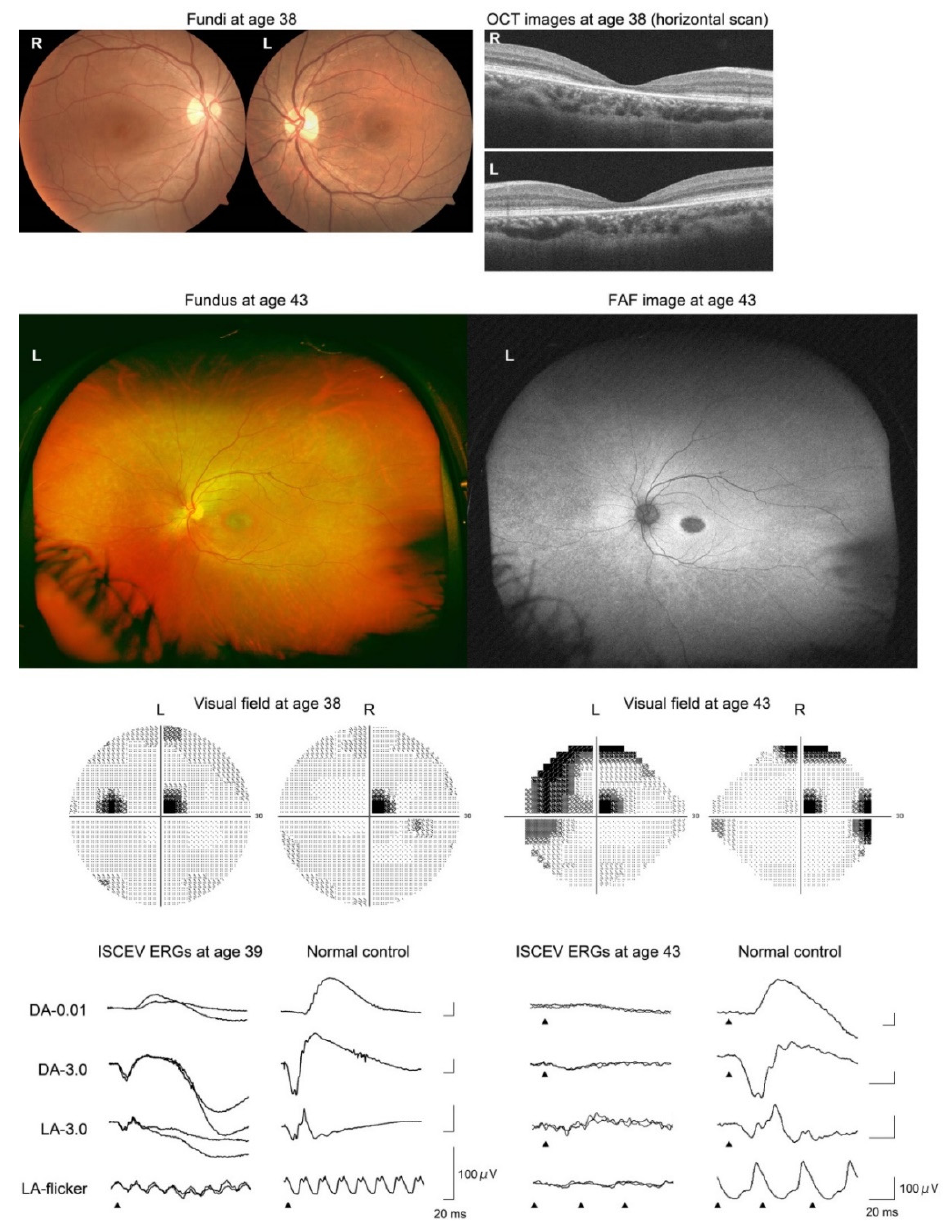
Figure 3. Results of fundus photography, fundus autofluorescence (FAF) imaging, optical coherence tomographic (OCT) imaging, Humphrey static visual field testing, and International Society for Clinical Electrophysiology of Vision (ISCEV)-standard full-field electroretinography (ERG) in Patient 1 (Jikei-176-1241). The fundus and FAF images were obtained by an ultra-wide-field fundus camera (Optos) at age 43 years. This patient had a homozygous variant, c.707_709dup, p.Arg236_Val237insGly, in the DRAM2